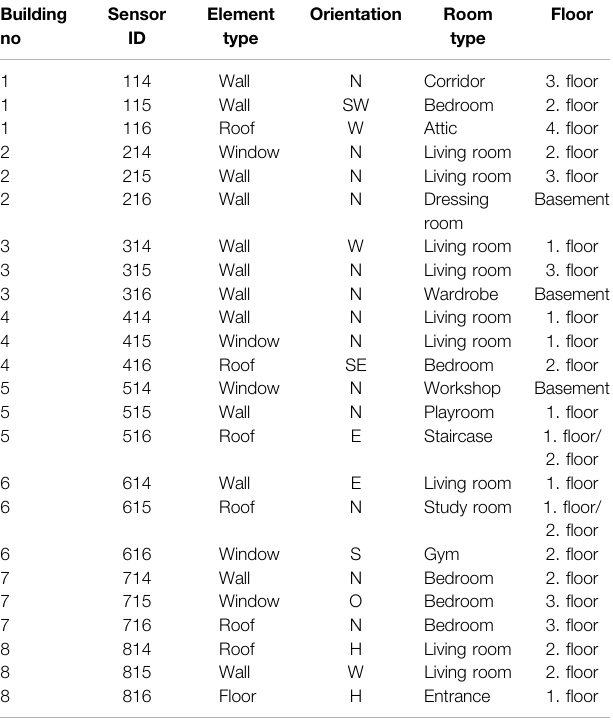
TABLE 3 | Location of U-value measurements (Orientation: N: north, E: east, S: south, W: west, H: horizontal). Building Sensor no ID